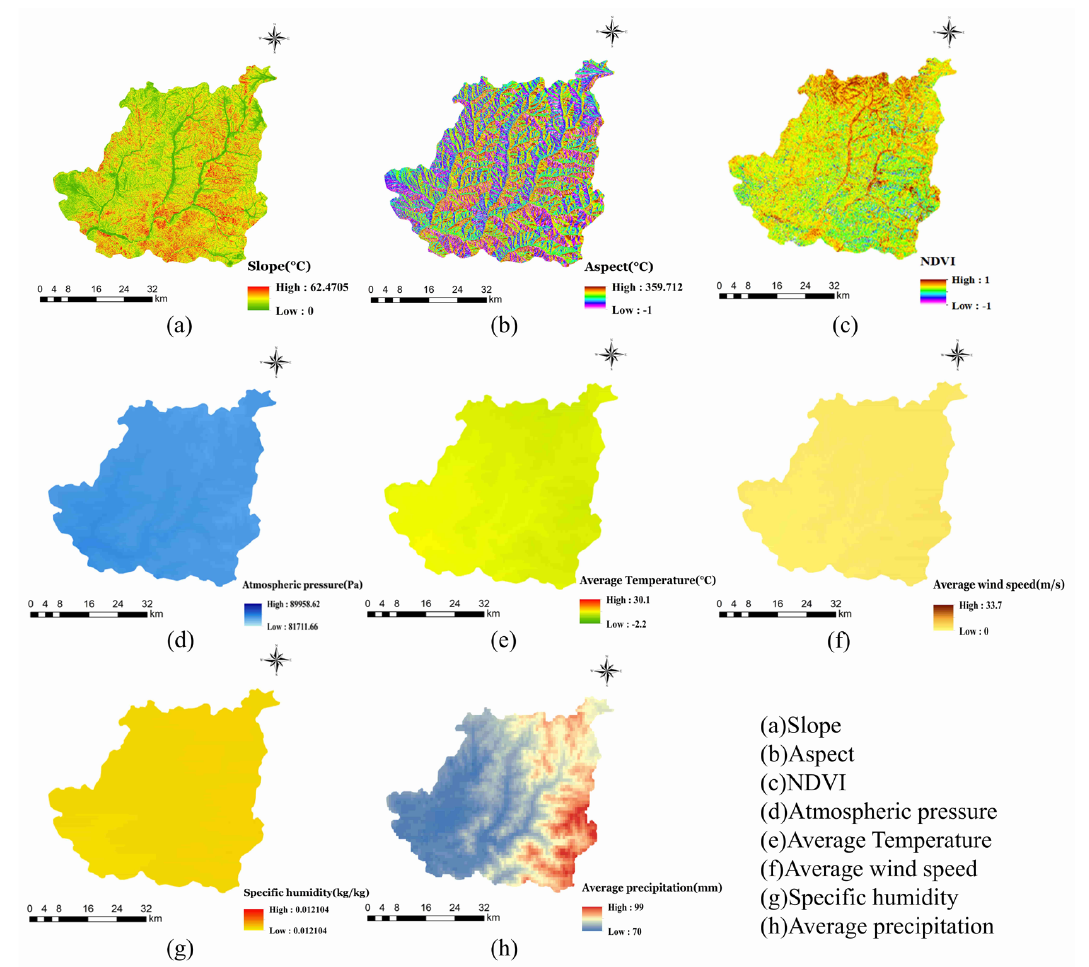
Figure 2. Forest fire influencing factor maps in 2020 for Chongli district, ZhangjiakouCity, Hebei Province, China.